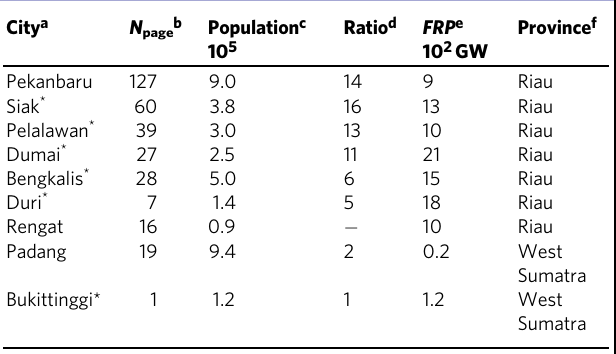
Table 1 Regional dependence of page numbers of articles mentioning both “ acute respiratory illness ” and “ city name ” .